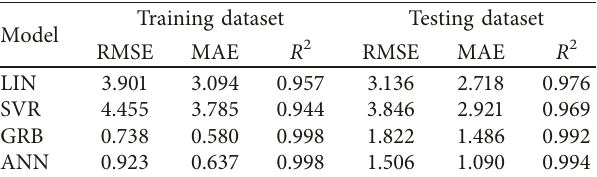
Figure 9: Comparison of experimental measurement and prediction of Ra on the testing dataset. Table 6: Performance of ML models for Vbmax prediction on the training and testing